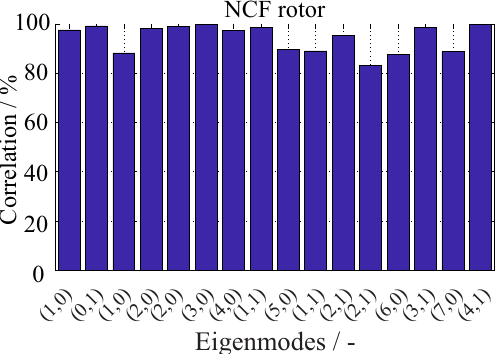
Figure 15. Statistical comparison between experimentally identified and numerically calculated changes of eigenmodes, using the correlation measure, for an undamaged